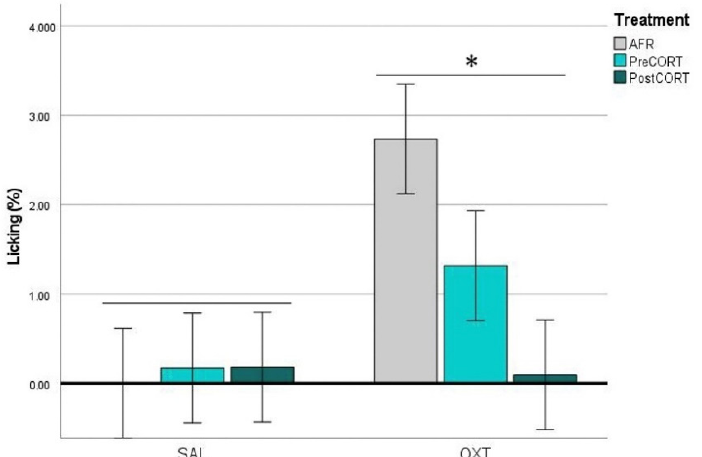
Figure 9. Percentage of paw-licking exhibited by the Demonstrators. Observer mice ( n = 16) were allowed to interact in proximity to the three Observer companions, each belonging to a different perinatal treatment. Half of the Observers received intranasal administration of oxytocin; the other half received saline. As a whole, Demonstrators showed increased levels of paw-licking when close to oxytocin-administered Observer companions (* p < 0.05). Error bars indicate mean ± SEM.